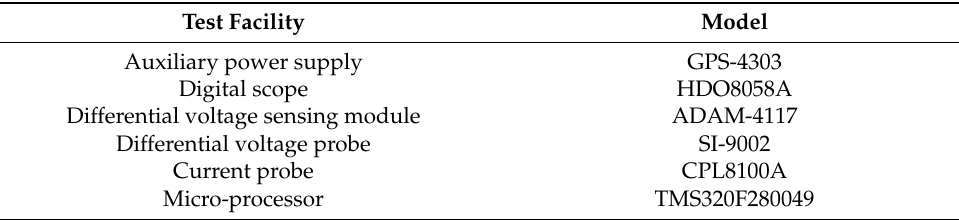
Table 4. Information of equipment prepared in the experiments.